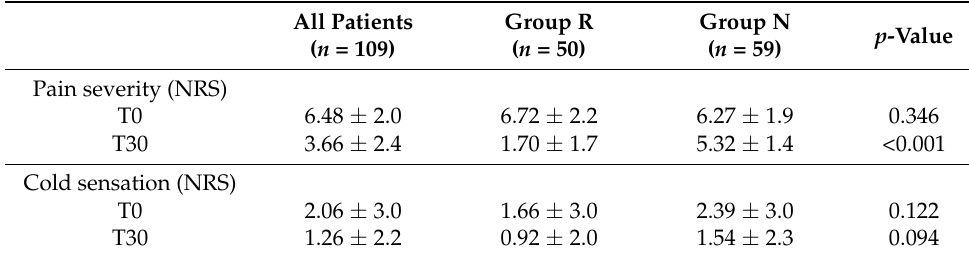
Table 4. Pain severity and cold sensation over